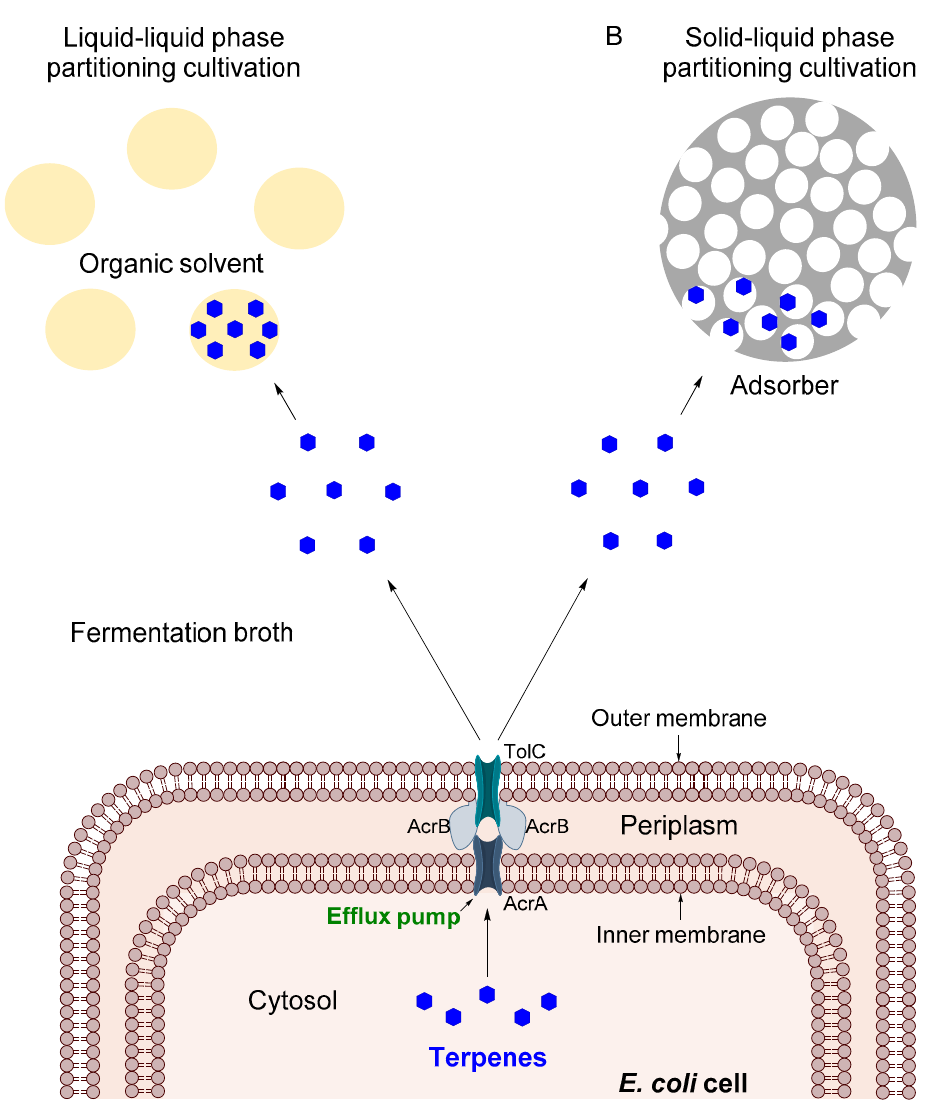
Figure 1. The mechanism for the in situ recovery of terpenes produced from metabolically engineered E. coli . ( A ) Liquid-liquid phase partitioning cultivation is carried out by liquid extractants (organic solvents), which extract the terpenes by hydrophobic interactions. ( B ) Solid-liquid phase partitioning cultivation utilizes solid extractants (adsorbers) and recovers the terpenes by adsorption. The tripartite efflux pump AcrAB-TolC is used as an example of a secretion system for hydrophobic molecules and its components are properly described.